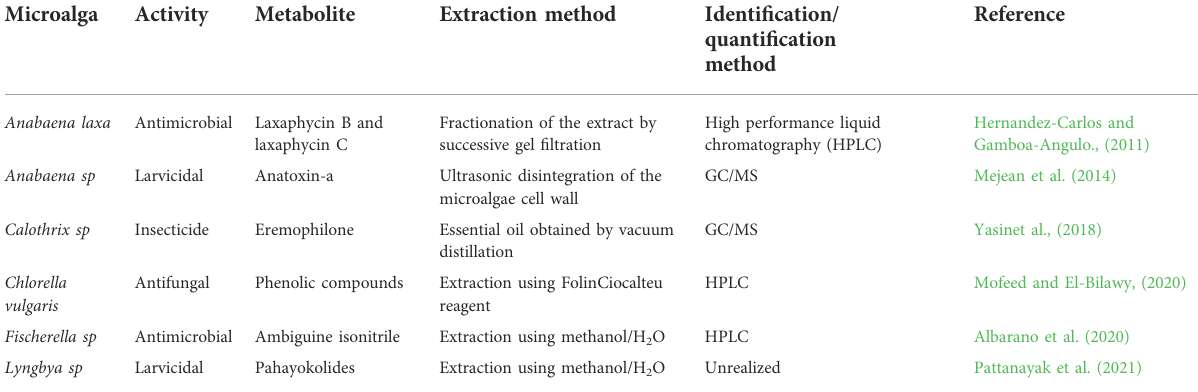
TABLE2 Chemical compounds foundinmicroalgaehavepotentialasbiopesticides.Adapted withthe permission fromTaylor &Francis Online(Costa et al.,